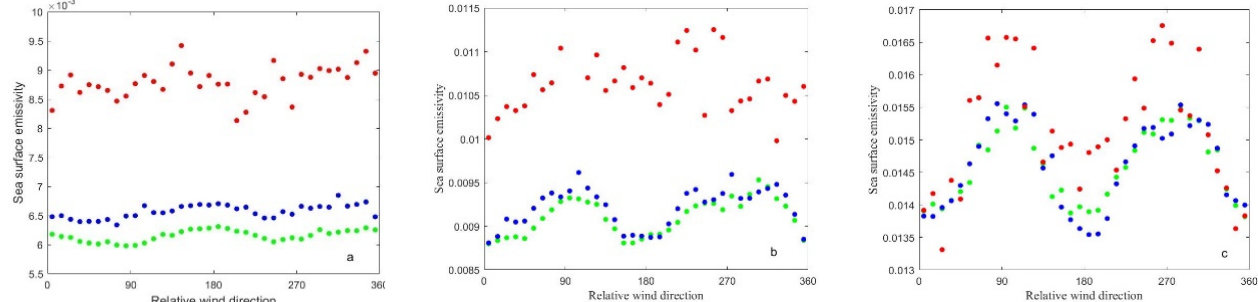
Figure 10. H-pol sea surface emissivity under the wind speed of 5 m/s ( a ), 10 m/s ( b ), and 15 m/s ( c ) for RR = 0 (green dots), 0 < RR < 2 mm/h (blue dots), and RR > 2 mm/h (red dots).